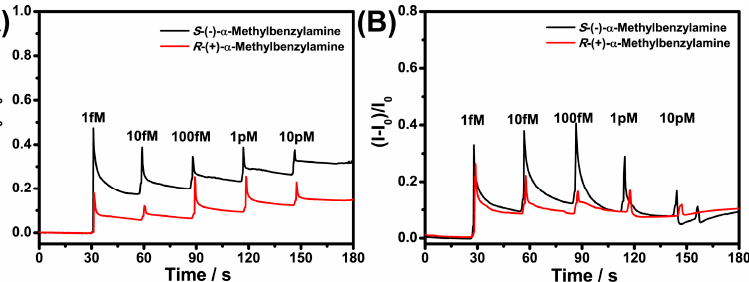
Figure 9. Recognition performance of Nafion–BSA-EG-MOSFET for α -Met enantiomers in 1% PBS ( A ) and 20-fold diluted FBS ( B ).